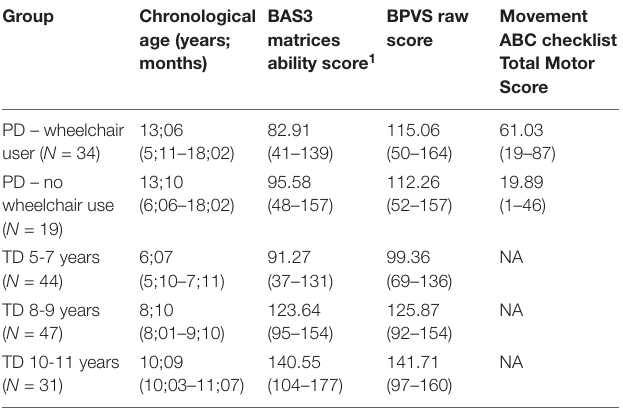
TABLE 2 | Participant details for the VR navigation task (mean and range). TABLE 3 | Cumulative number of errors made on the VR navigation task across learning trials.